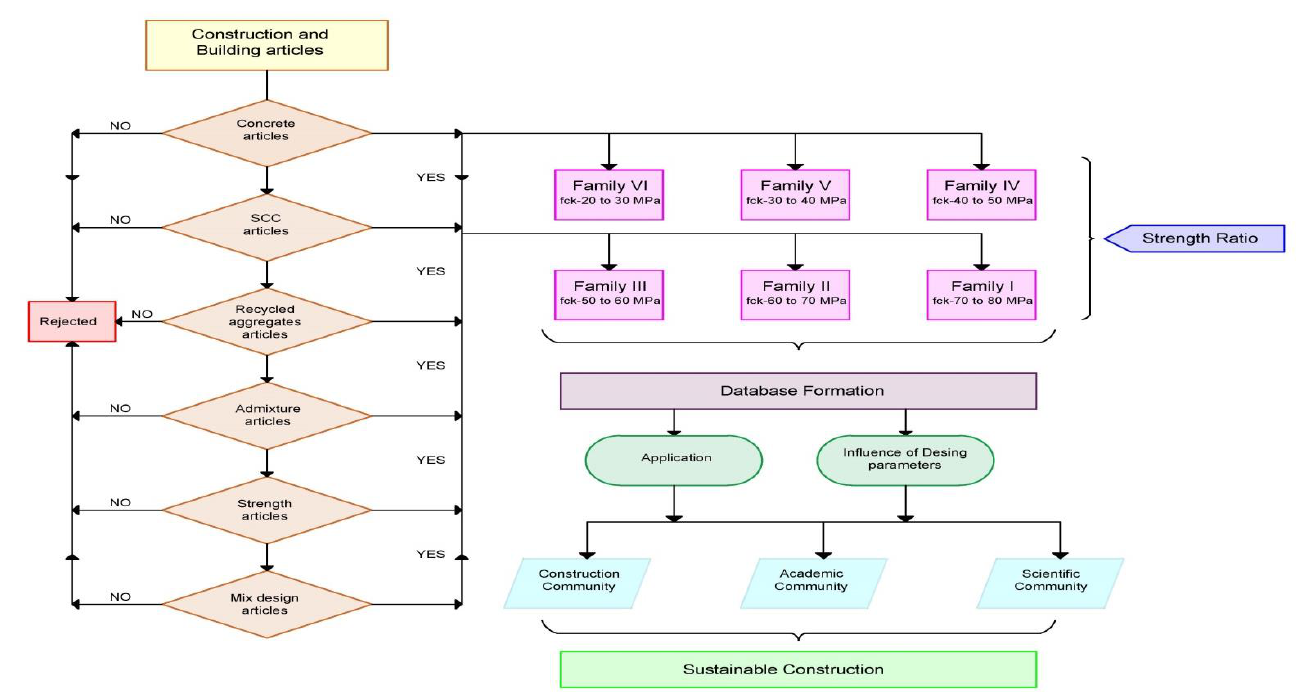
Figure 1. Review Figure 1. Review methodology.